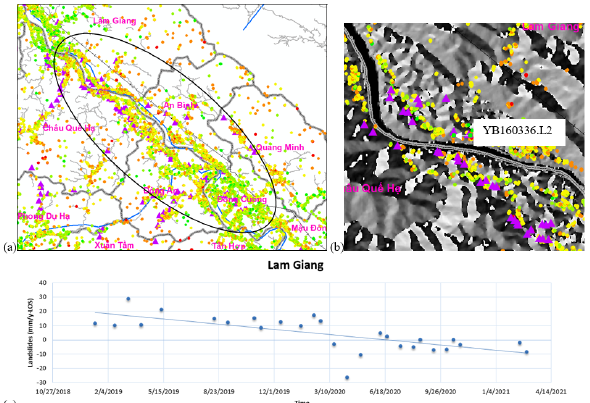
Figure 9. (a) Distribution of permanent scatter points showing landslide rate, (b) the positions of PS points matched with survey point in Phong Du Thuong commune are superimposed on aspect map, (c) the chart of landslide point selected from (b).